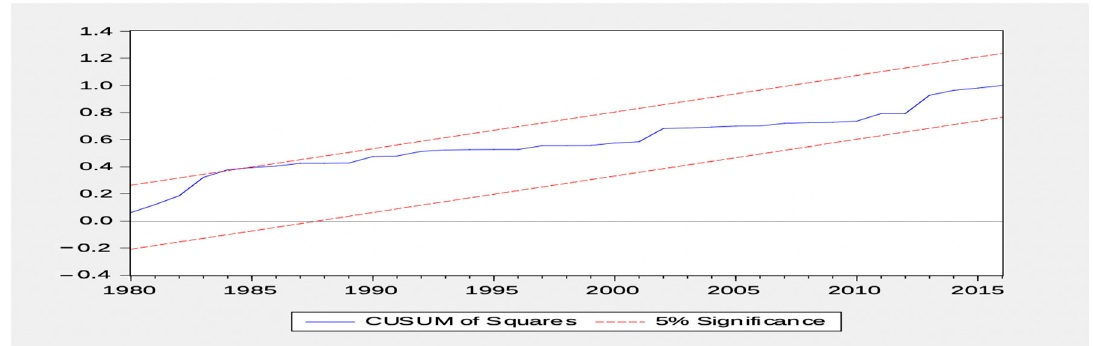
Figure A8. CUSUM Test (OMAN).